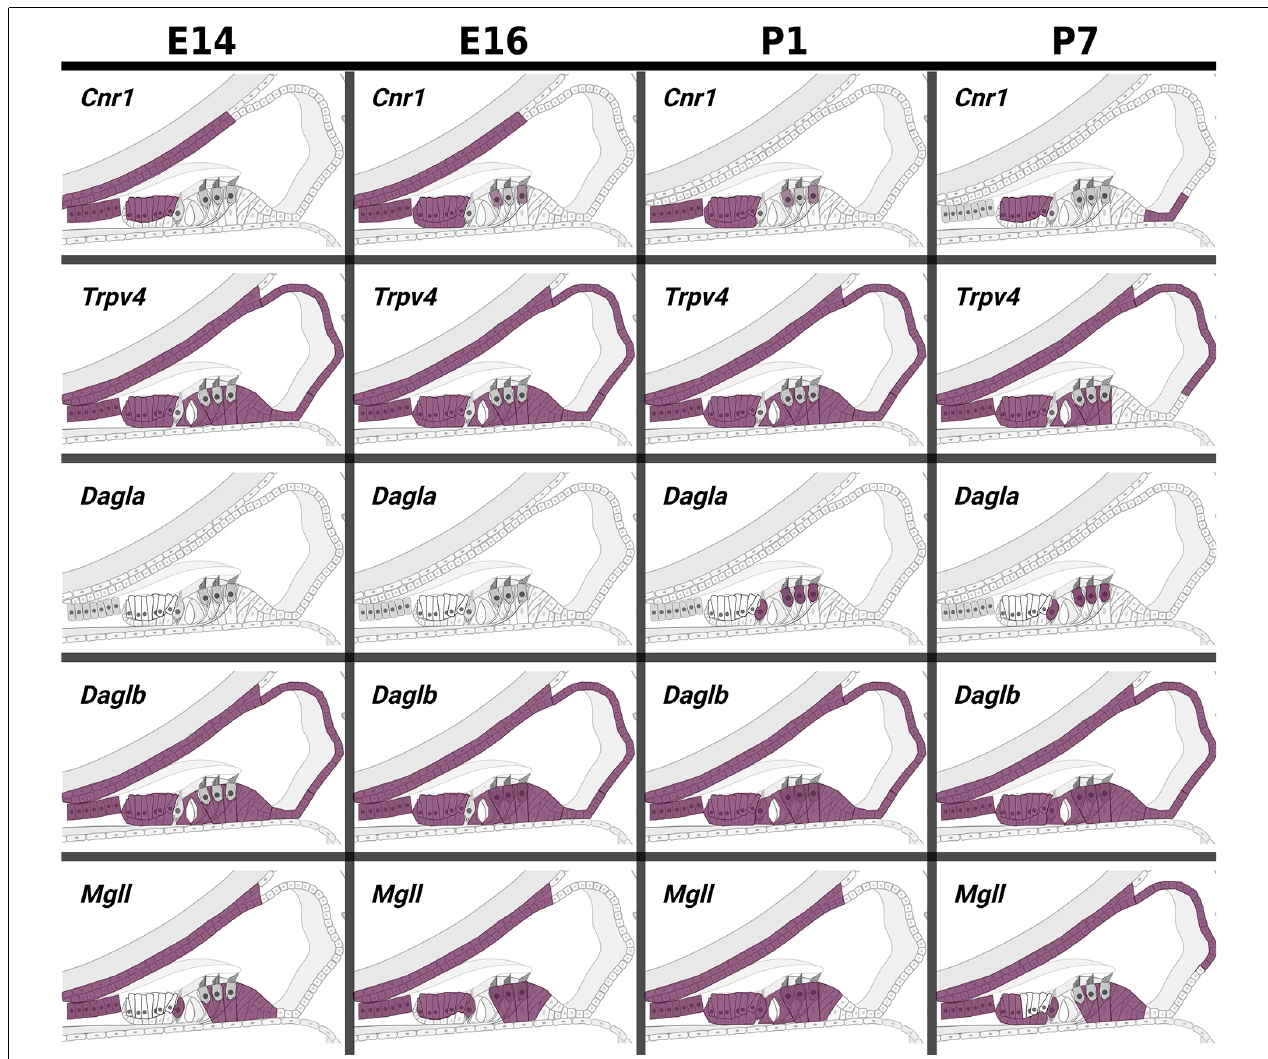
FIGURE 5 | In pseudo hue-visualization of the patterns of expression of ECS components in late embryonic and early postnatal cochlear duct. Using data from Kolla et al. (2020), the distribution of several ECS component transcripts are plotted onto a schematic of the mammalian cochlear duct. Purple color indicates areas where transcripts are likely to be detected based on bioinformatic grouping of scRNA-seq data from mouse cochlear epithelia at embryonic days E14 and E16, and postnatal days P1 and